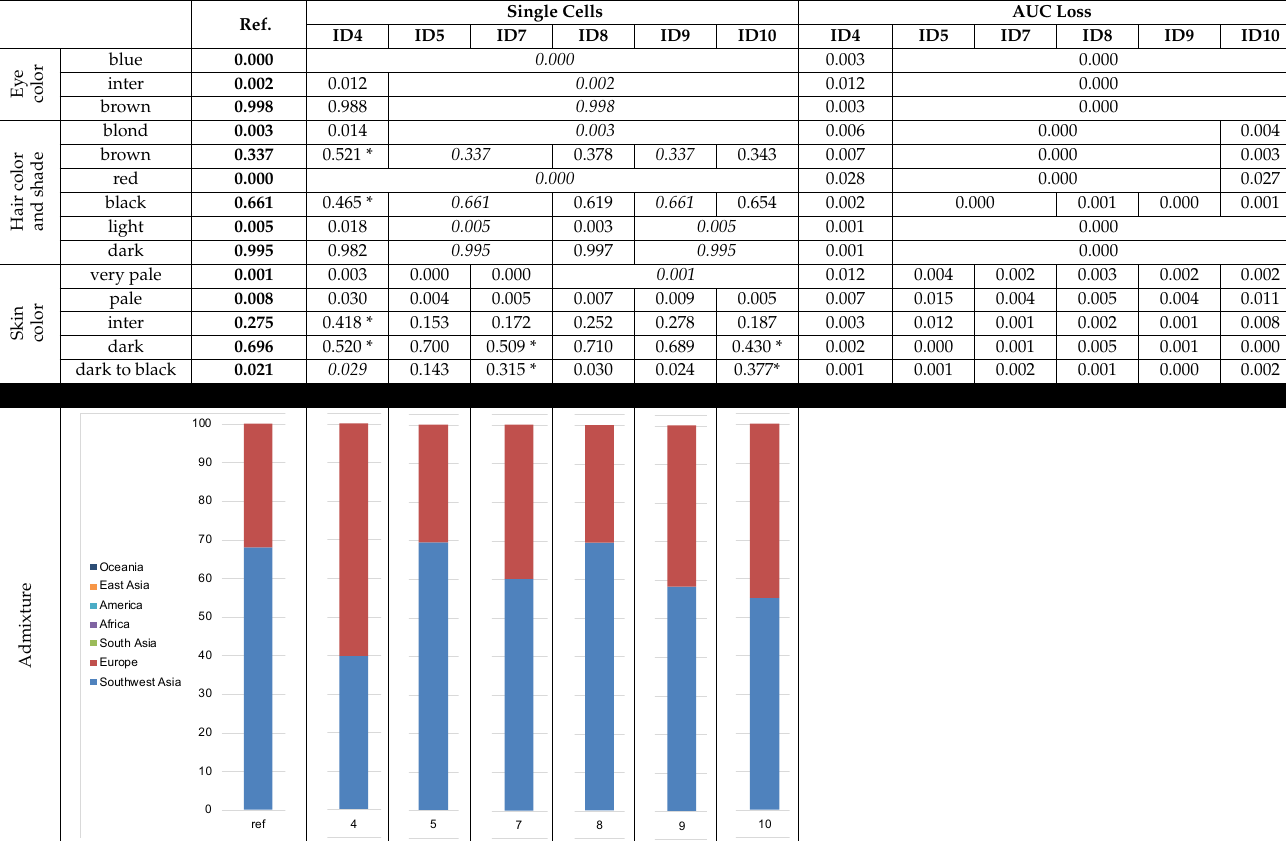
the highest p -value was brown with 0.521, while black was 0.465. The profile missed the rs16891982 marker (imbalanced), for which the correct CC genotype is strongly associated Table 2. Phenotype and ancestry prediction summary for selected single cells (with calling rate of at least 90%). p -values and Table 2. Phenotype and ancestry prediction summary for selected single cells (with calling rate of at least 90%). p -values and Table 2. Phenotype and ancestry prediction summary for selected single cells (with calling rate of at least 90%). p -values and Table 2. Phenotype and ancestry prediction summary for selected single cells (with calling rate of at least 90%). p -values and Table 2. Phenotype and ancestry prediction summary for selected single cells (with calling rate of at least 90%). p -values and Table 2. Phenotype and ancestry prediction summary for selected single cells (with calling rate of at least 90%). p -values and Table 2. Phenotype and ancestry prediction summary for selected single cells (with calling rate of at least 90%). p -values and with black hair color [32,33]. Despite the difference, the final prediction was black hair color admixture proportions were compared with the results obtained from reference (ref.) sample ( italic indicates identical values; admixture proportions were compared with the results obtained from reference (ref.) sample ( italic indicates identical values; admixture proportions were compared with the results obtained from reference (ref.) sample ( italic indicates identical values; admixture proportions were compared with the results obtained from reference (ref.) sample ( italic indicates identical values; admixture proportions were compared with the results obtained from reference (ref.) sample ( italic indicates identical values; admixture proportions were compared with the results obtained from reference (ref.) sample ( italic indicates identical values; admixture proportions were compared with the results obtained from reference (ref.) sample ( italic indicates identical values; for all samples. The biggest variance was observed for skin color due to several markers * indicates different values that affected the interpretation of the results). AUC-Area Under Curve. * indicates different values that affected the interpretation of the results). AUC-Area Under Curve. * indicates different values that affected the interpretation of the results). AUC-Area Under Curve. * indicates different values that affected the interpretation of the results). AUC-Area Under Curve. * indicates different values that affected the interpretation of the results). AUC-Area Under Curve. * indicates different values that affected the interpretation of the results). AUC-Area Under Curve. * indicates different values that affected the interpretation of the results). AUC-Area Under Curve. relevant for prediction missing. Furthermore, skin color is the most complex phenotypic trait to predict, and incomplete profiles make it even more difficult [34,35]. For only three Single Cells Ref. Ref. Ref. Ref. Ref. Ref. cells, the final prediction would be the same as the reference, namely dark skin with 70% probability. For samples ID4, ID7, and ID10, the p -value for dark skin was only around 0.5, and for the last two samples (ID7 and ID10), the second-highest was dark to black, which would incorrectly suggest the skin color to be darker. Table 2. Phenotype and ancestry prediction summary for selected single cells (with calling rate of at least 90%). p -values and admixture proportions were compared with the results obtained from reference (ref.) sample ( italic indicates identical values; * indicates different values that affected the interpretation of the results). AUC-Area Under Curve. Ref.